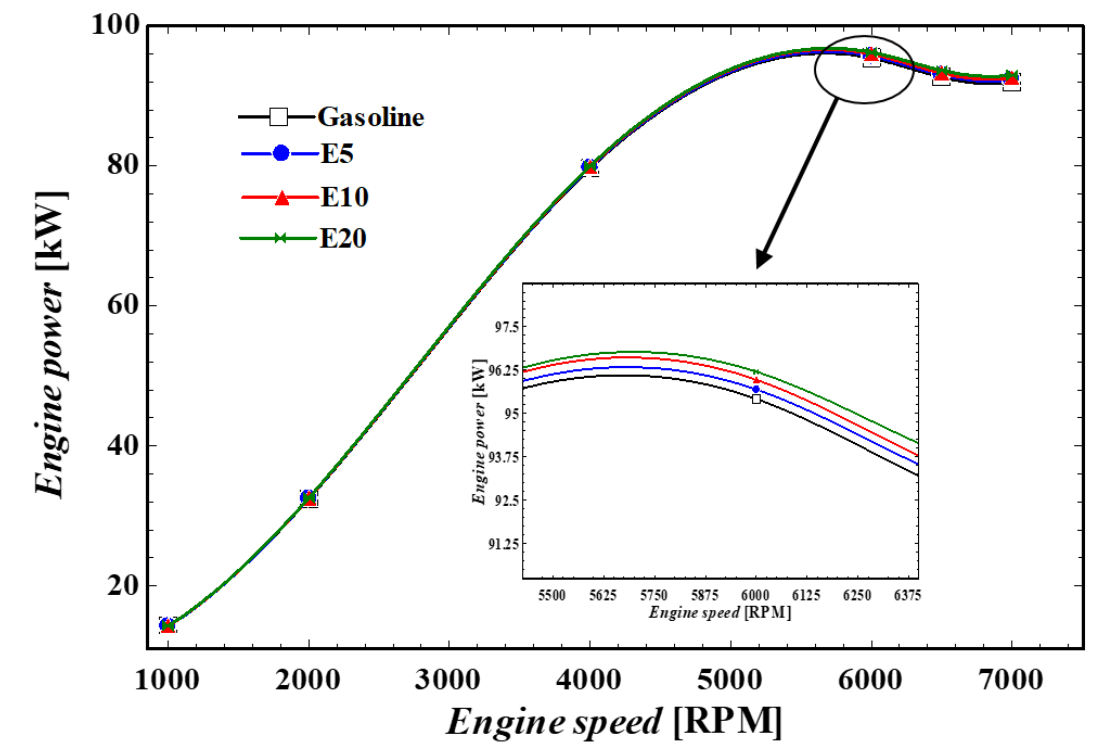
Figure 3. The engine power at various engine speeds at different fractions of ethanol.